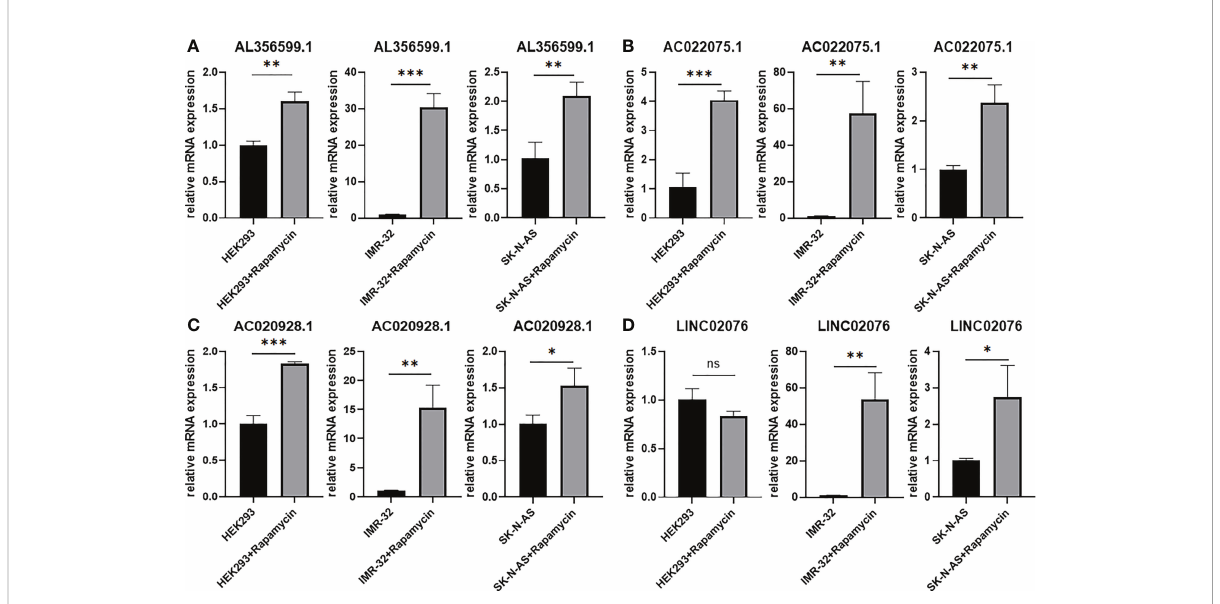
FIGURE 11 The expression of autophagy-related four-lncRNA (A) AL356599.1 (B) AC022075.1 (C) AC020928.1 (D) LINC02076 in autophagy-activated cell lines. Results are representative of three independent experiments, ns p > 0.05; * p < 0.05; ** p < 0.01; *** p <